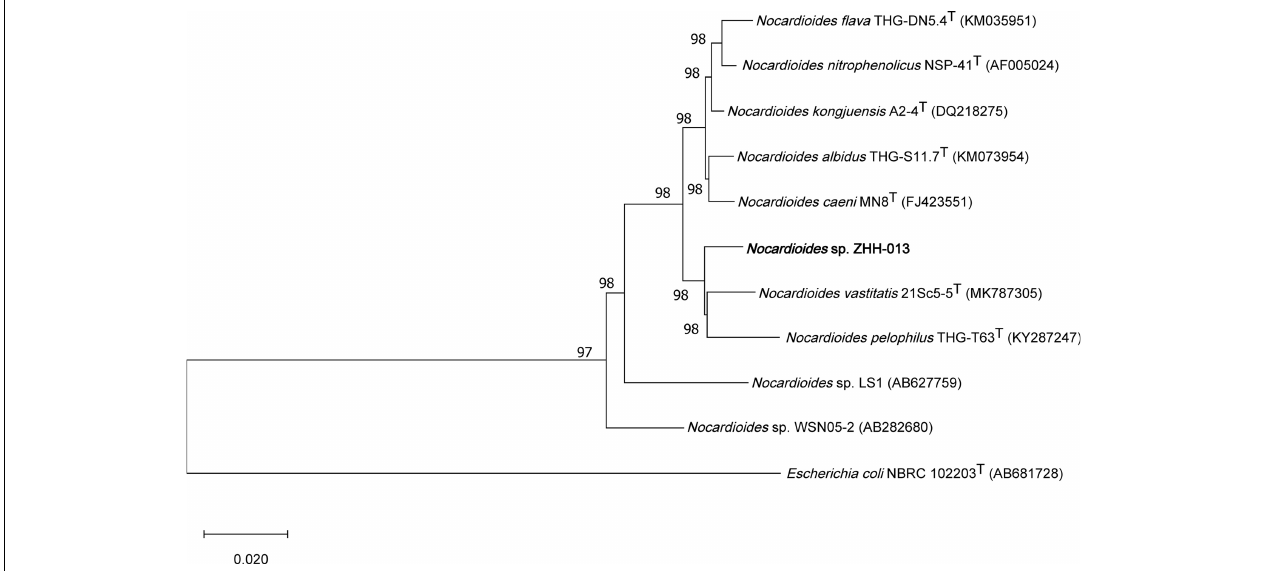
FIGURE 1 | Phylogenetic tree, including Nocardioides sp. ZHH-013, based on neighbor-joining analysis of 16S rDNA sequences.